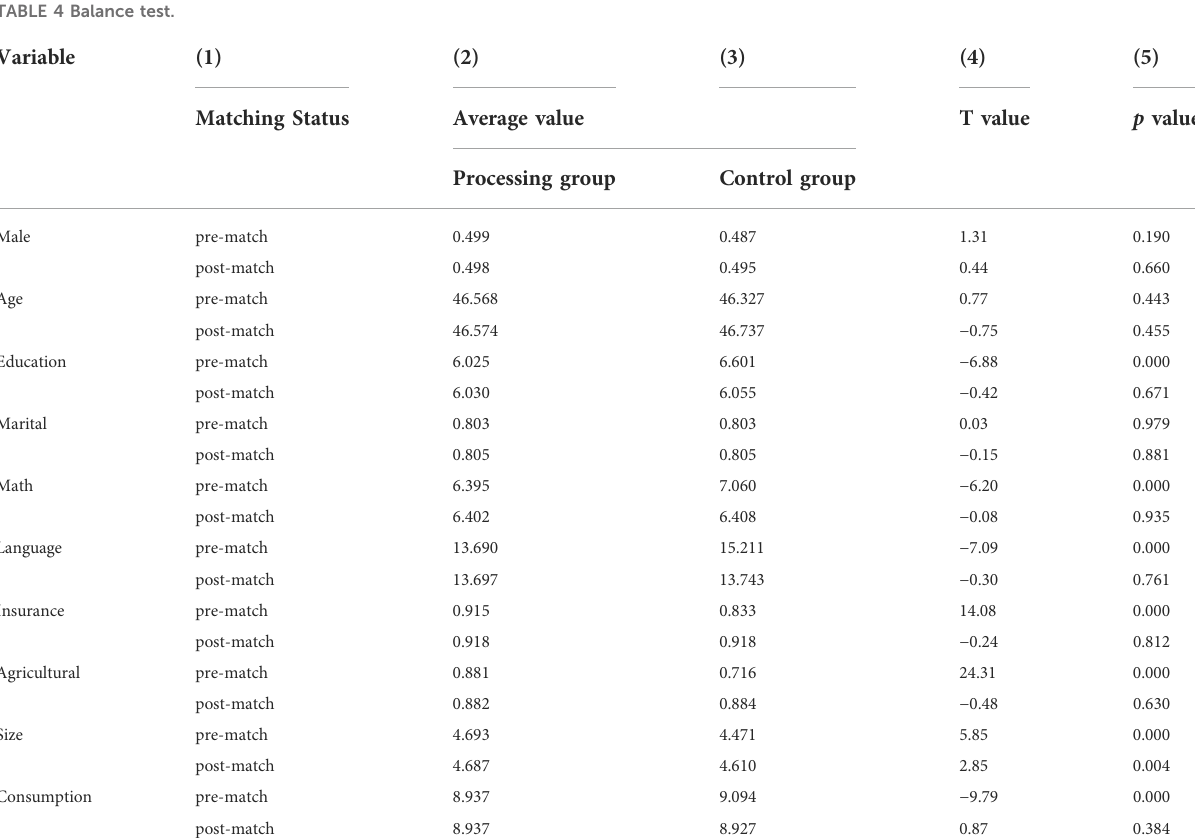
TABLE 4 Balance